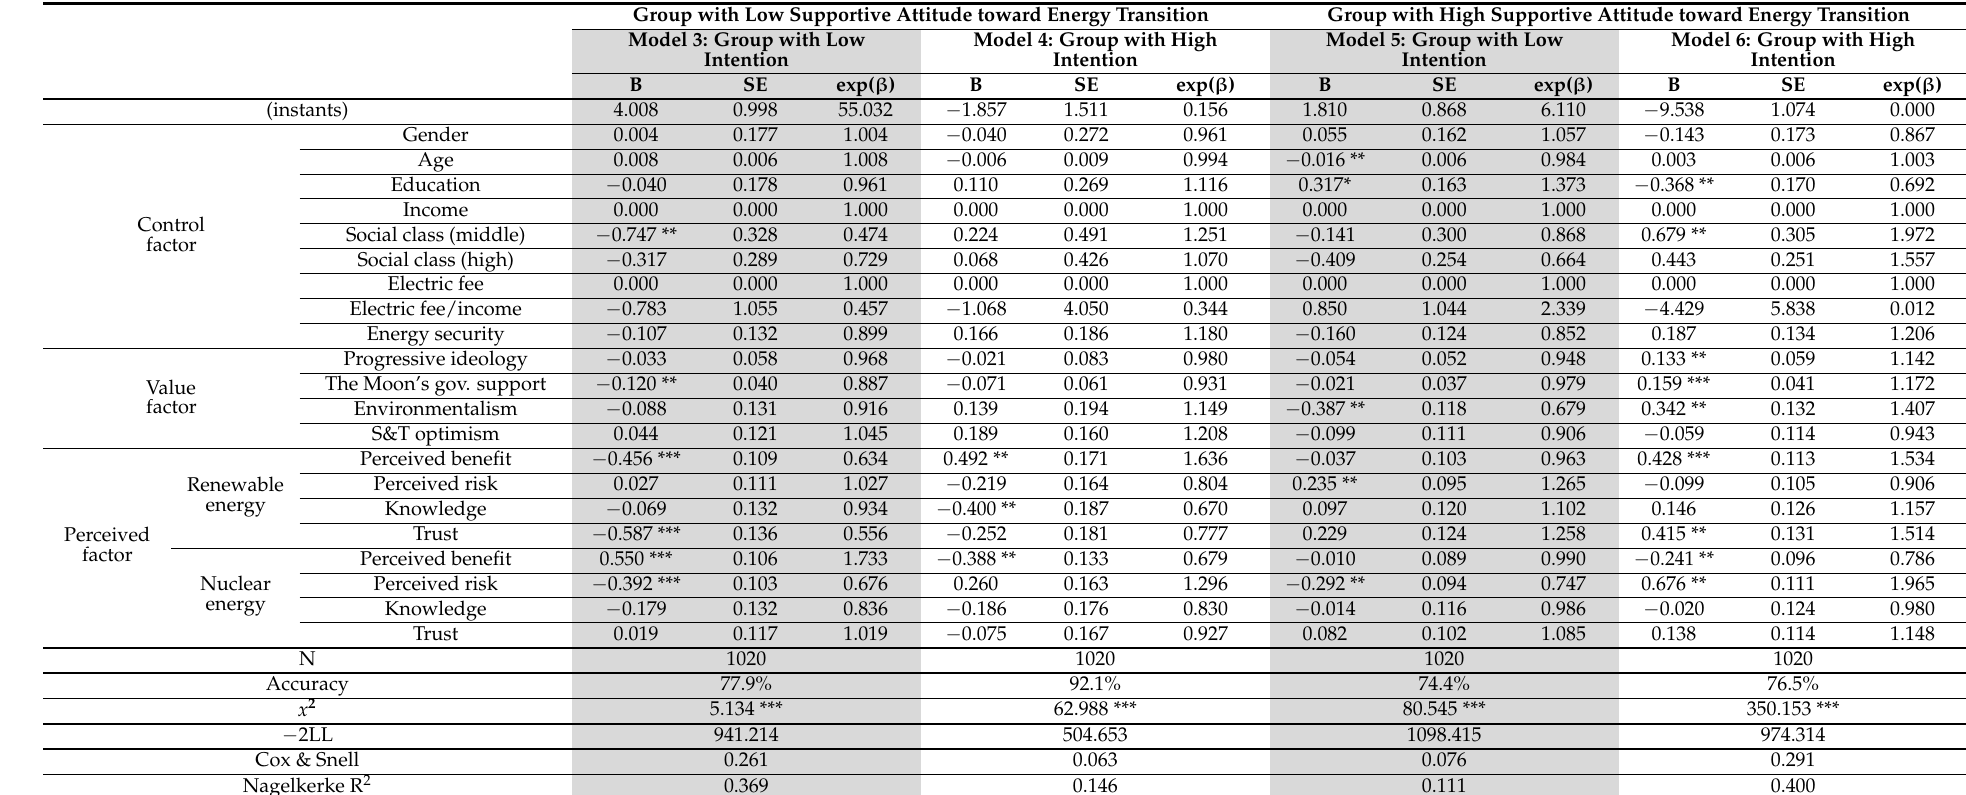
Table 4. Logistic